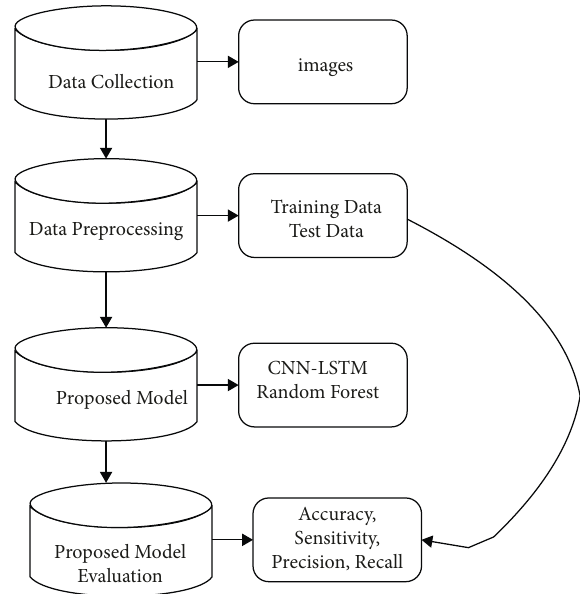
Figure 1: Proposed model for breast cancer.